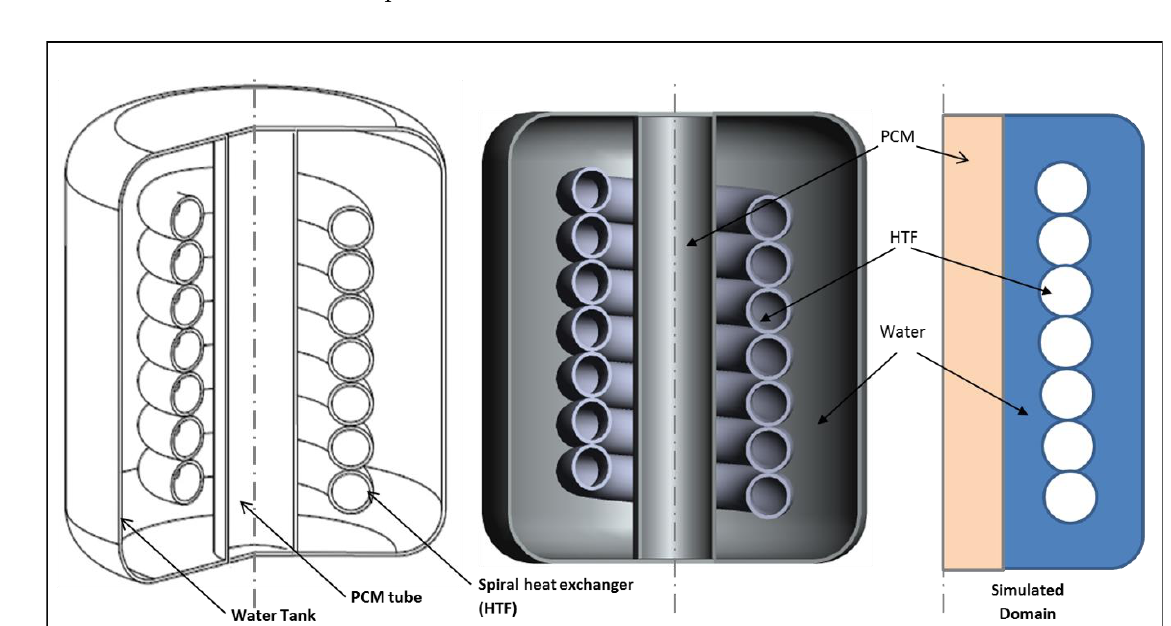
Figure 2. Numerical modeling and meshing of the studied geometry.